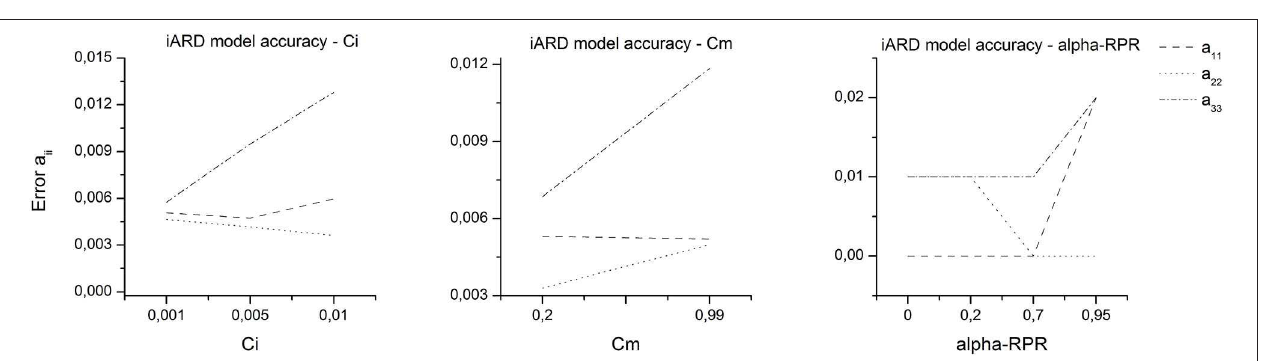
FIGURE 11 | Prediction error of the iARD-RPR